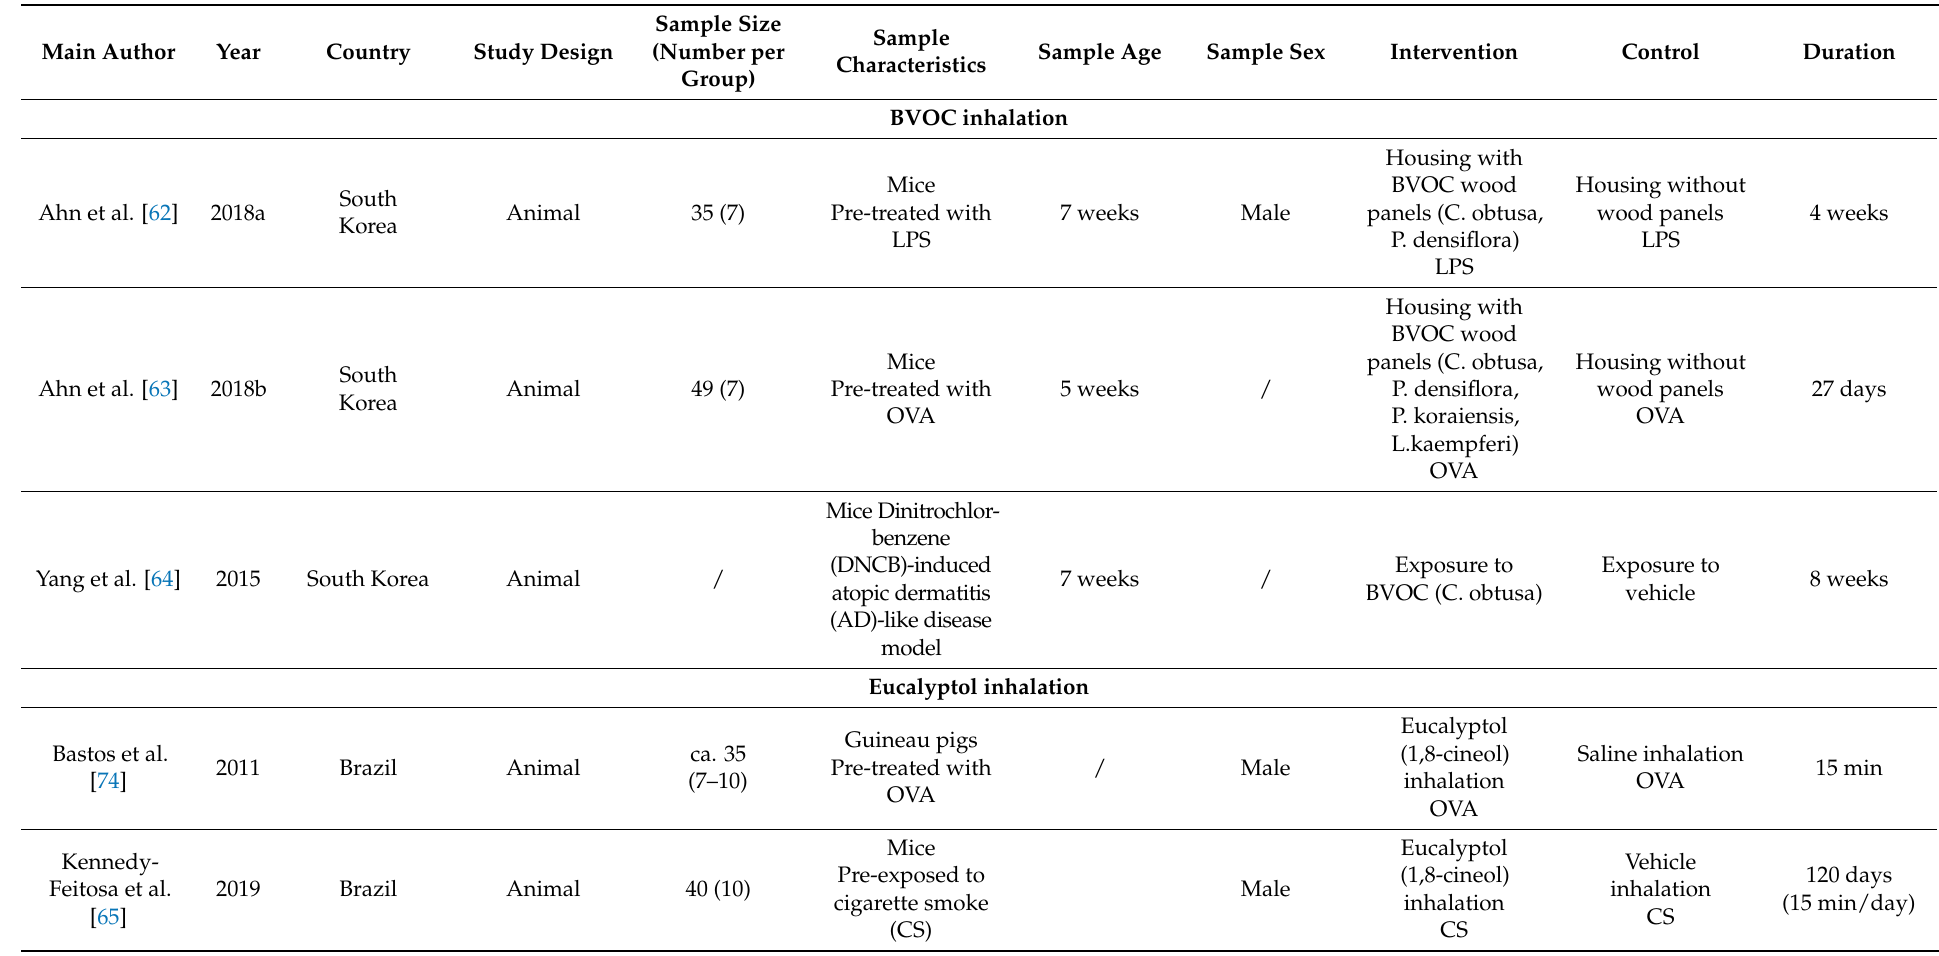
Table 2. Characteristics of included animal